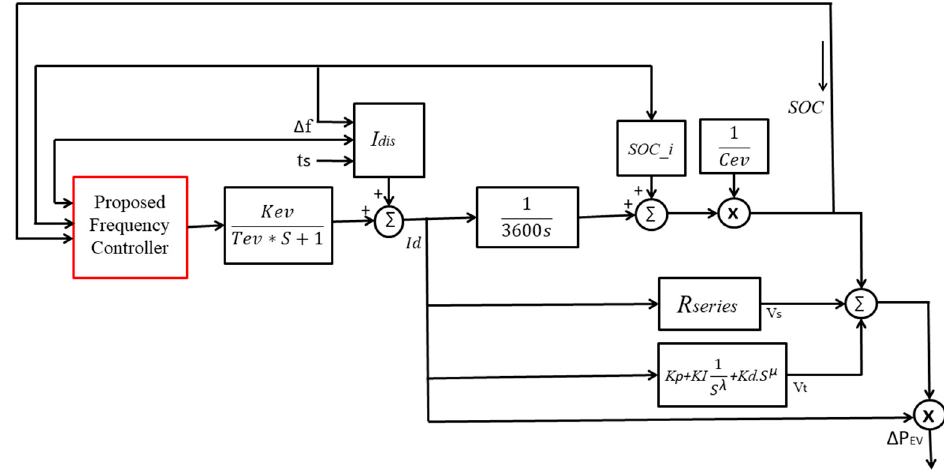
Figure 3. EV model.